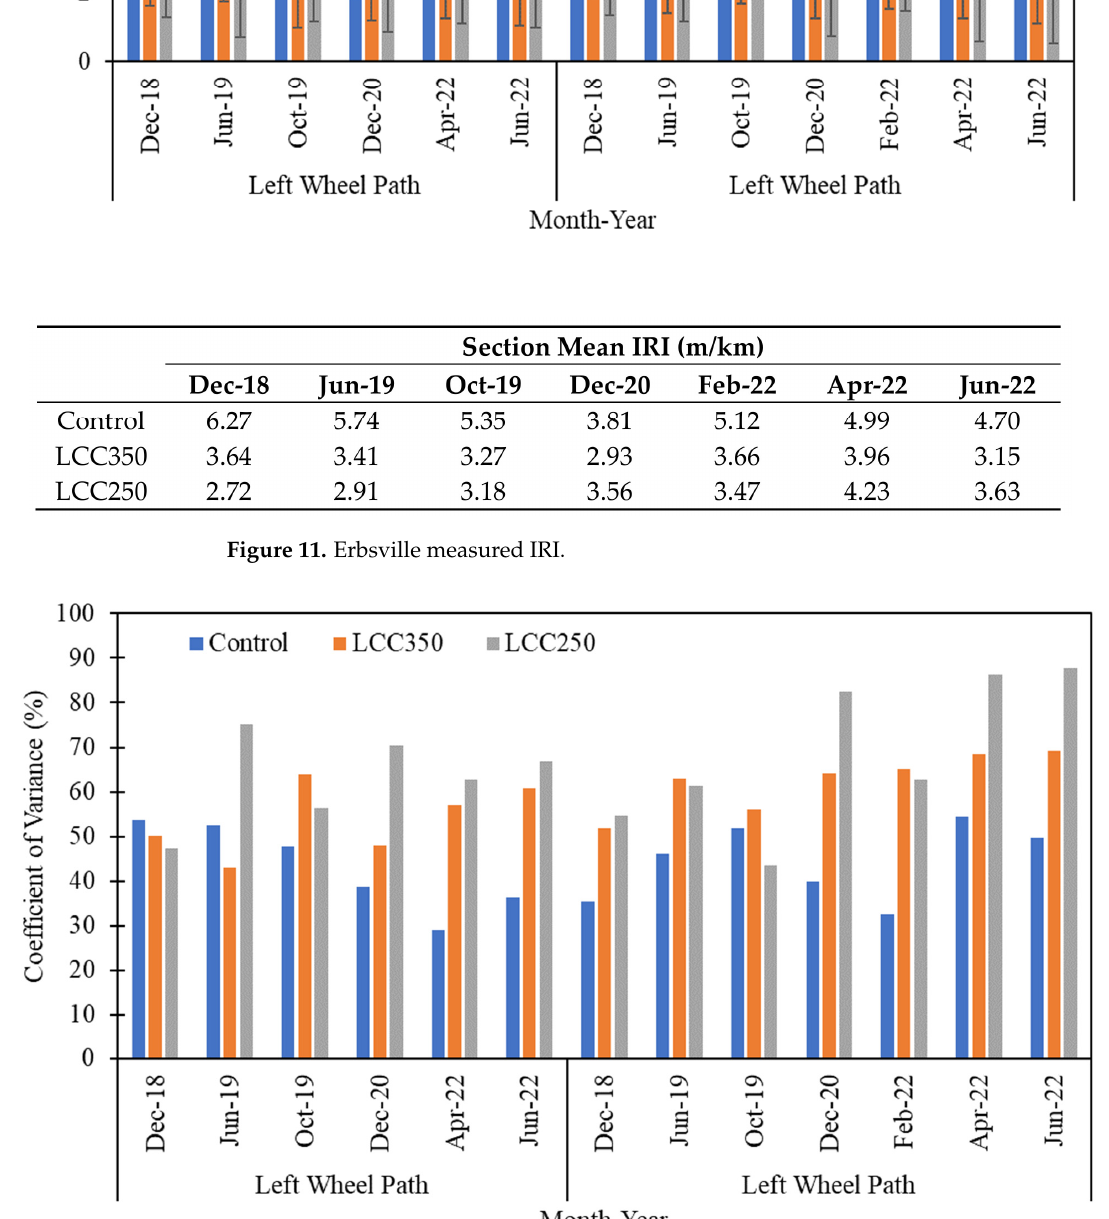
Figure 13. Notre Dame Drive Southbound Lane measured IRI.